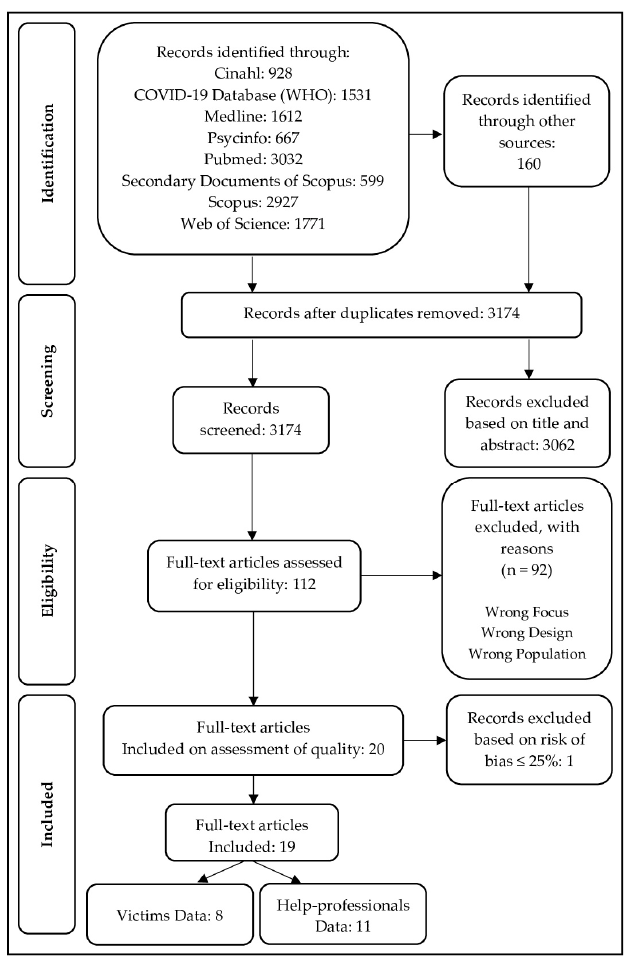
Figure 1. Flow chart of research articles selection, according to PRISMA criteria. Table 1. Results of quality assessment of the cross-sectional studies (Victims Data).